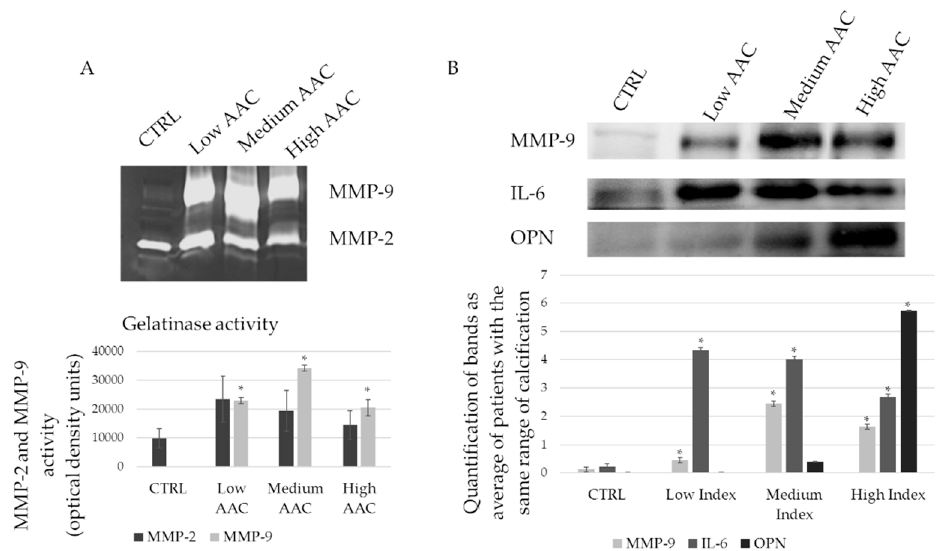
Figure 3. Matrix remodelling, inflammation and calcification in AAA tissues. ( A ) Gelatin zymography performed on tissue lysates of patients with different degree of calcification and the respective quantification of matrix metalloproteinase -2 and -9 (MMP-2 and MMP-9) activity; ( B ) Immunoblot on MMP-9, interleukin-6 (IL-6), and osteopontin (OPN) on tissue lysates of patients with different degree of calcification. The graph shows the relative quantification. * statistically significant with respect to control p < 0.05.